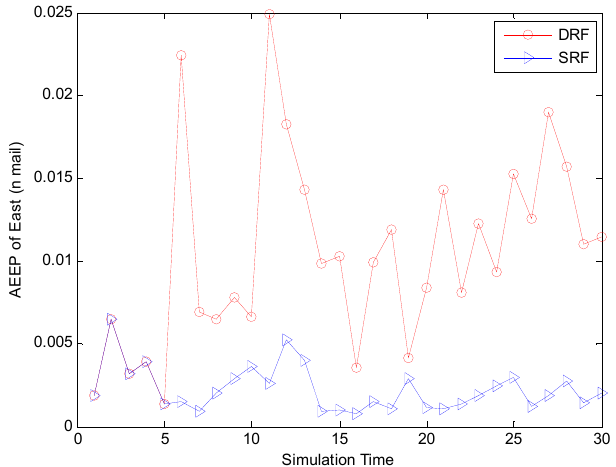
Figure 4. The absolute estimation error of east position.